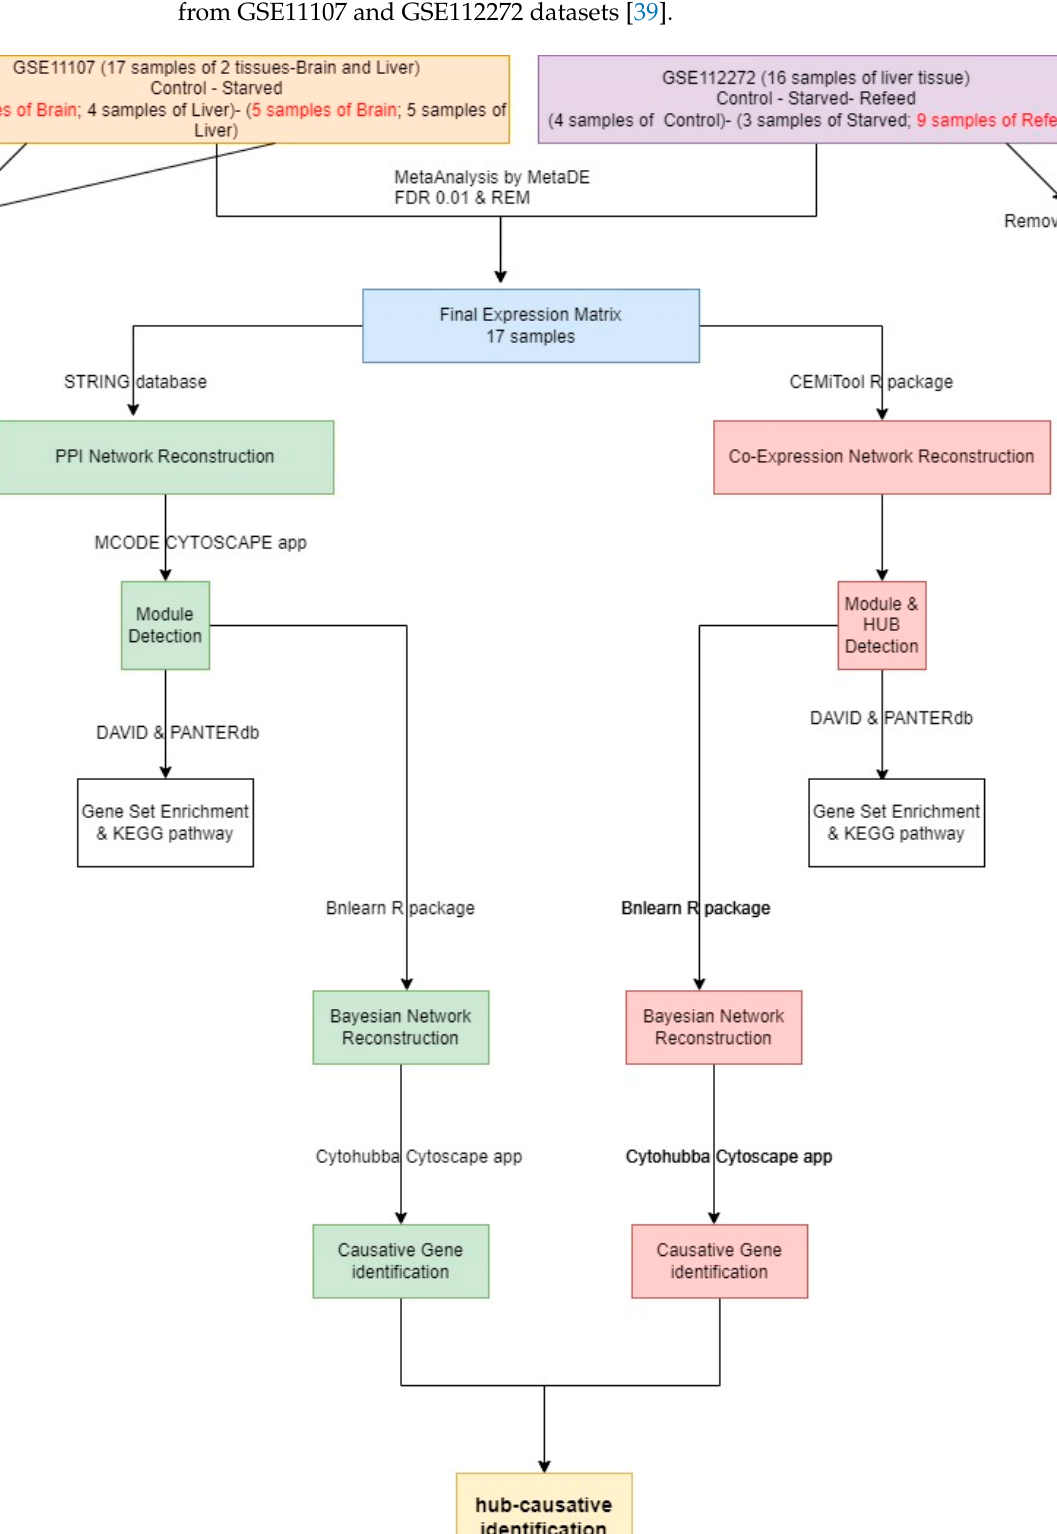
Figure 1. Pipeline used for investigating starvation on zebrafish in this